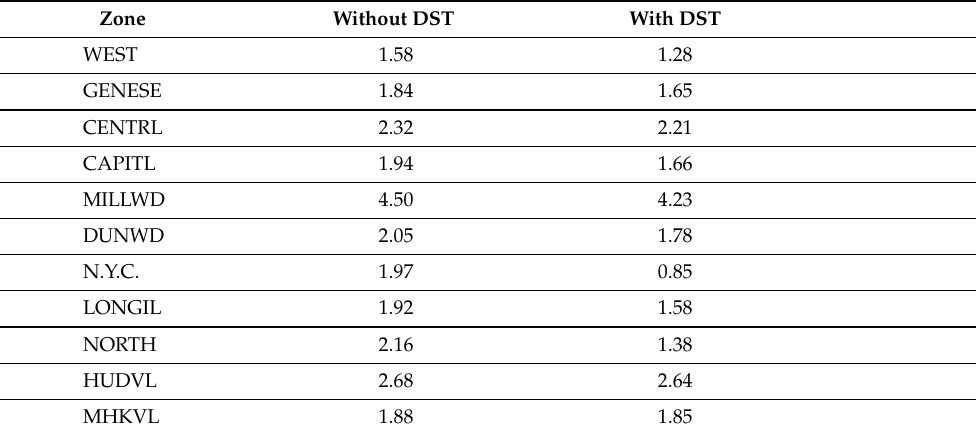
Table 6. DST effect for selected time intervals, for all NYISO zones.